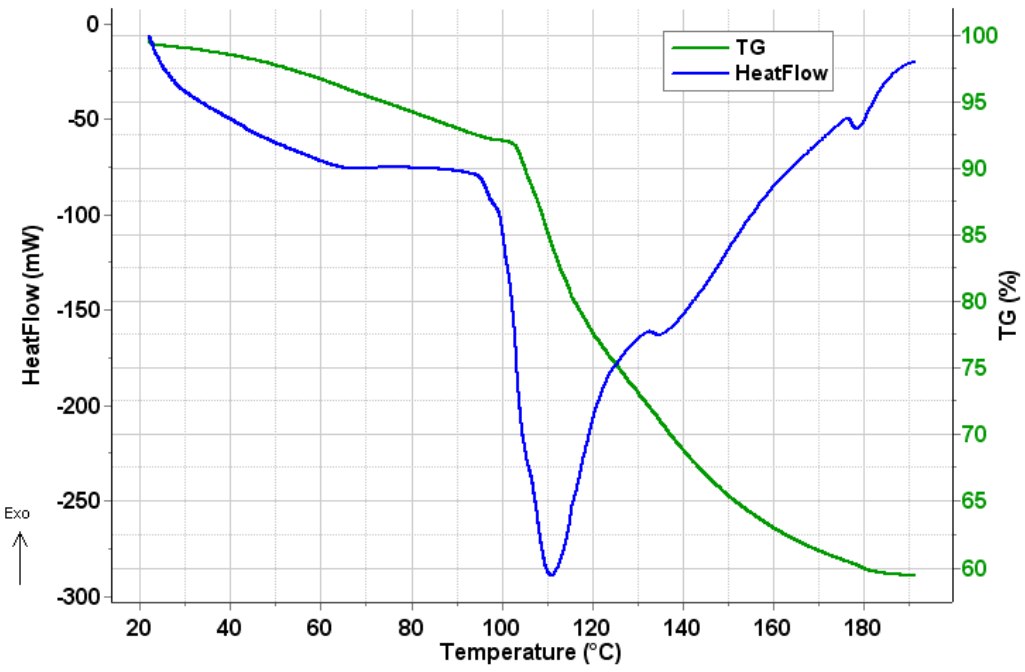
Figure 5. Mass (TG) and heat flow traces of the PHB polymer.